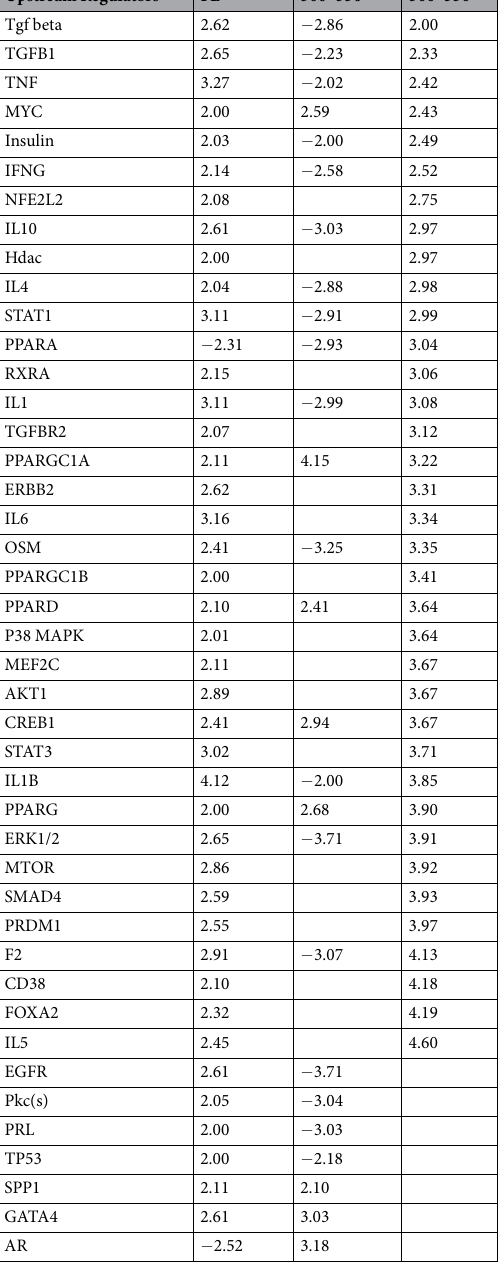
Table 2. The FL induced regulators were primarily observed following two discrete wavebands of light (300–350 and 500–550 nm). While both regions have significant gene identity sharing with the FL exposed brain samples (Fig. 5), the 300–350 nm region oppositely modulated genes compared to FL and the 500– 550 nm region modulated genes in the same direction as FL. The full list of modulated upstream regulators is presented in Table